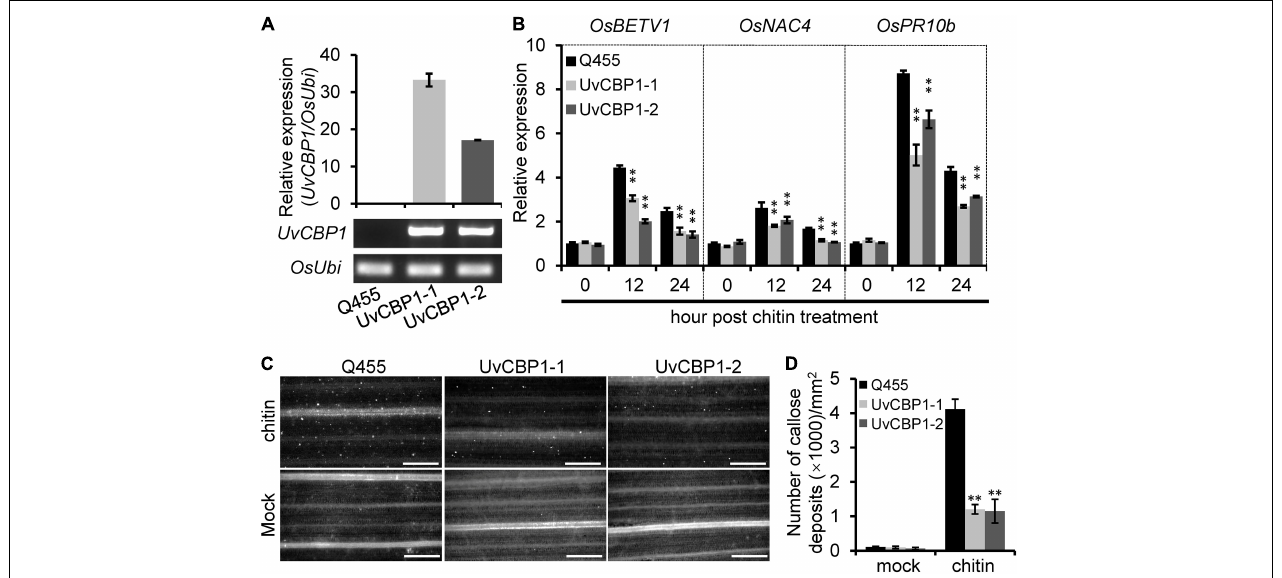
FIGURE 4 | In planta expression of UvCBP1 compromises rice immunity triggered by chitin. (A) Expression analysis of UvCBP1 in transgenic rice plants. The relative expression was determined by RT-qPCR using OsUbi as the reference gene. No expression of UvCBP1 was detected in the wild-type Q455. (B) Expression analysis of defense-related genes in chitin-treated leaves of UvCBP1 -expressing plants and Q455. Relative expression levels of indicated genes were determined using OsUbi as the reference gene. Data are represented as means ± SD of three biological replicates. (C,D) Chitin-induced callose deposition. Leaves of indicated rice plants were treated with chitin for 20 h and subjected to aniline blue staining. Representative microscopy images were shown (C) and the number of callose deposits was recorded (D) . Bar data were mean ± SD of four biological replicates. Scale bar, 50 µ m. Asterisk in this figure indicates significant difference determined by Student’s t test ( ∗∗ P <